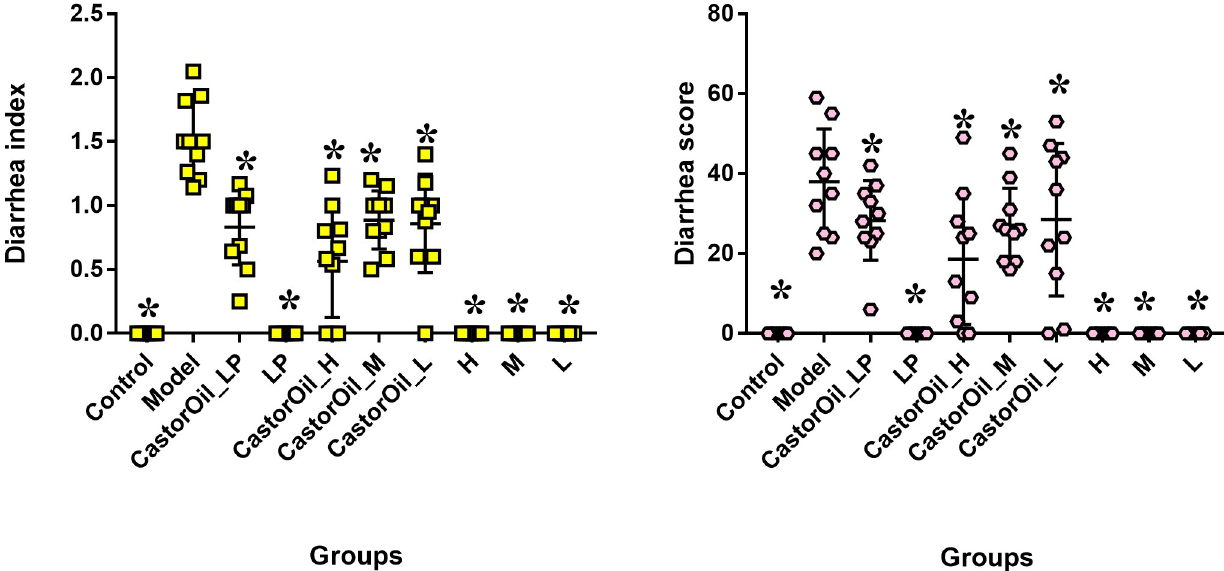
Fig 2. Estimates of diarrhea index and diarrhea score(n = 10). The effect of castor oil administration diarrhea score and index of mice. Castor oil increased the diarrhea score and index, while FengLiao decreased them. LP (loperamide), H (high dose of FengLiao), M (medium dose of FengLiao), L (low dose of FengLiao). 1 g/ml FengLiao (H), 0.5 g/ml FengLiao (M), 0.25g/ml FengLiao (L) and 5mg/kg loperamide were pretreated in CastorOil_H, H, CastorOil_M, M, CastorOil_L, L, CastorOil_LP, LP groups once a day for three days respectively. After 30 min at last times drug administration, 0.5ml castor oil was used to induce diarrhea in CastorOil_H, CastorOil_M, CastorOil_L and CastorOil_LP groups for 4 h and the stool characteristics were observed and calculated. Y axis shows diarrhea index or diarrhea score. X axis represents groups’ name. � p < 0.05 versus model group, ANOVA Test.